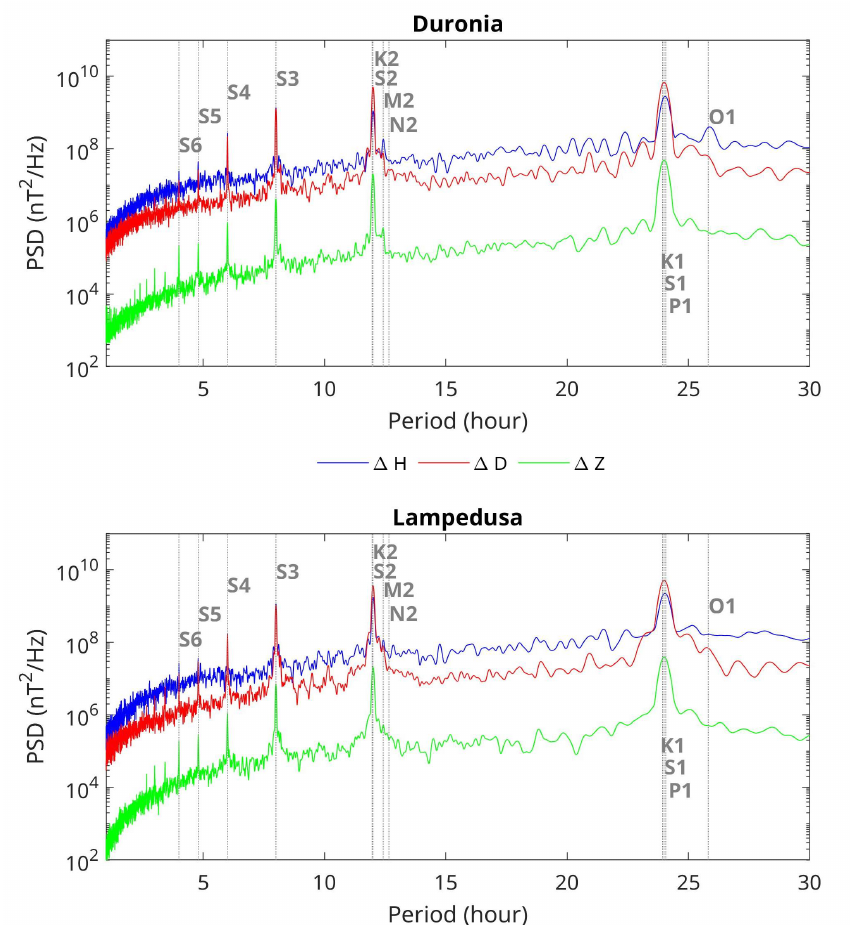
Figure 2. Multitaper power spectral densities for the ∆ H (blue), ∆ D (red) and ∆ Z (green) at DUR ( top ) and LMP ( bottom ) by using multitaper method for the years 2017–2018. Tidal mode periods are indicated with vertical gray dotted lines. In both panels, ∆ H and ∆ D spectra are multiplied by a factor 40 and 20, respectively, to make curves distinguishable from each